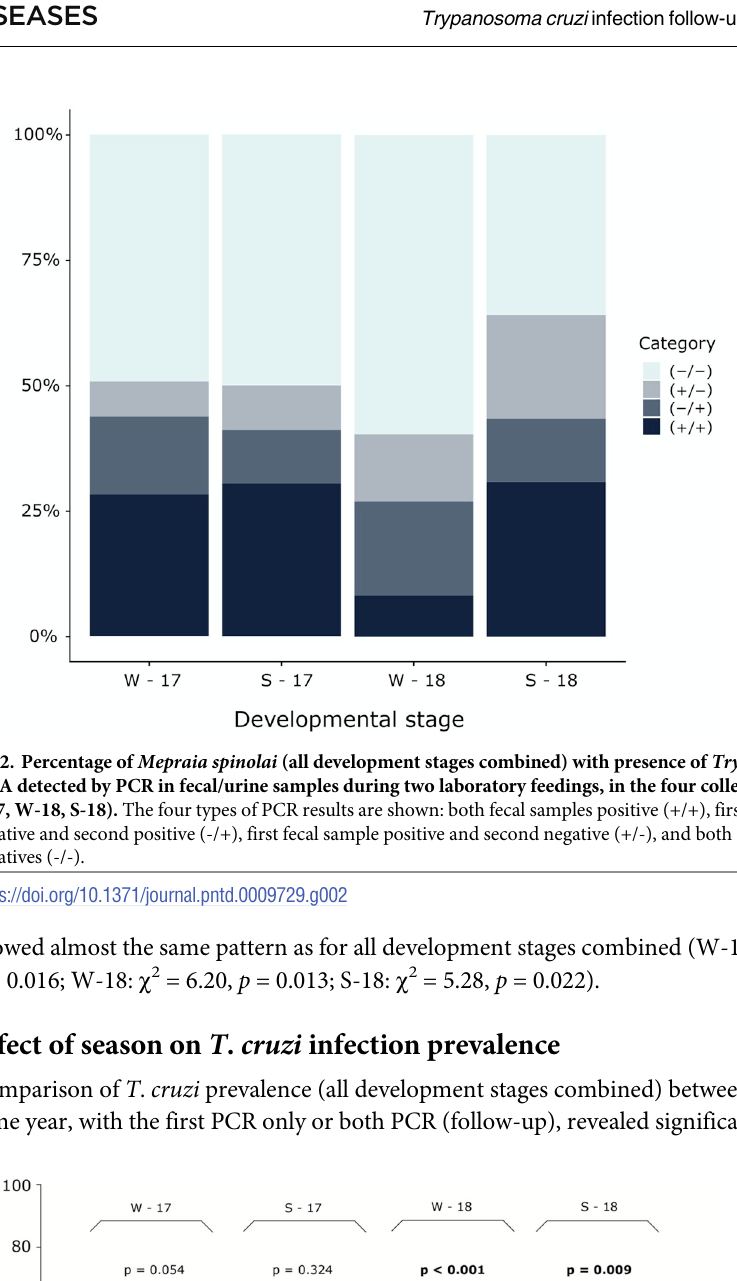
Comparison of T . cruzi prevalence (all development stages combined) between seasons of the same year, with the first PCR only or both PCR (follow-up), revealed significant differences for